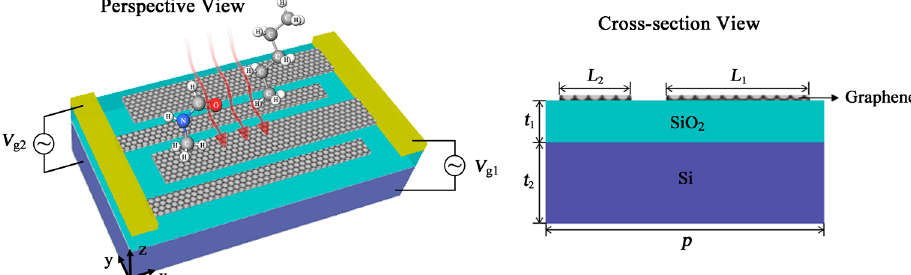
Figure 1. Schematic of multi-resonant graphene-based biosensor (MRGB). L 1 and L 2 ( L 1 > L 2 ) denote the widths of the wider and narrower graphene nanoribbons, respectively. t 1 and t 2 are the thicknesses of SiO 2 and Si. p is the periodic graphene nanoribbons (GNRs) array pitch. The permittivity of SiO 2 and Si used in the simulation are chosen from Ref. [25]. In order to